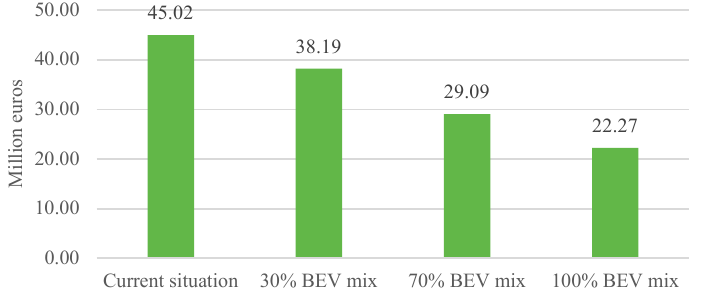
Fig. 3. Yearly noise external costs with different BEV proportions in Latvia’s passenger car and LCV